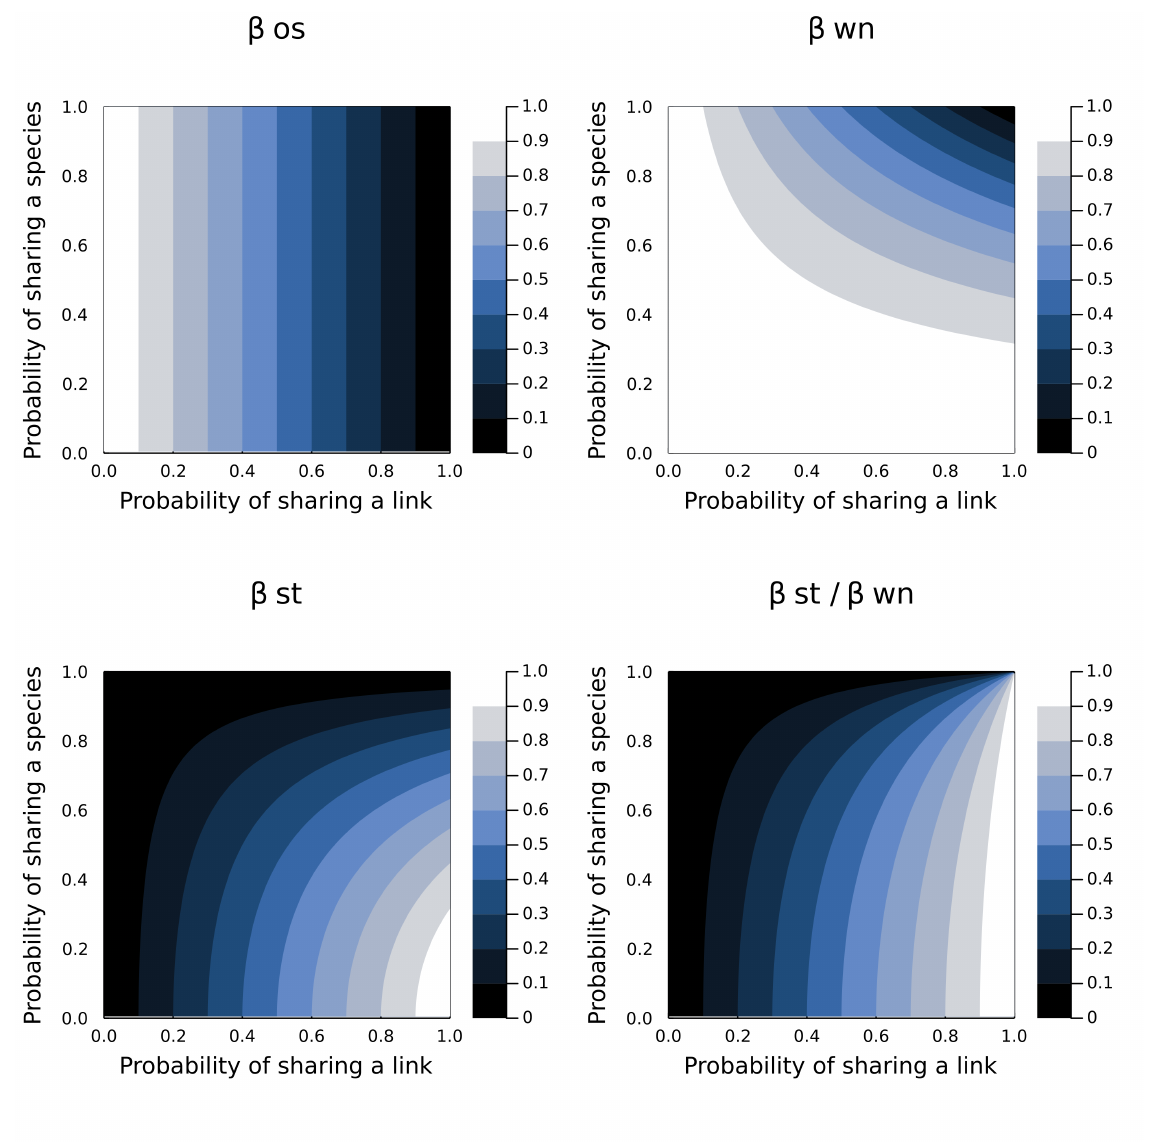
Figure 2 – Values of β os , β wn , β st , and β st /β wn as a function of the probability q or sharing a link ( x -axis), and the probability p of sharing a species ( y -axis). Larger values indicate more dissimilarity, such that for p = q = 1 the dissimilarity as measured by β wn = 0 , and for p = q = 0 the dissimilarity as measured by β wn = 1 . As expected, the relative importance of turnover ( β st ) is maximal when there is no rewiring, and when turnover